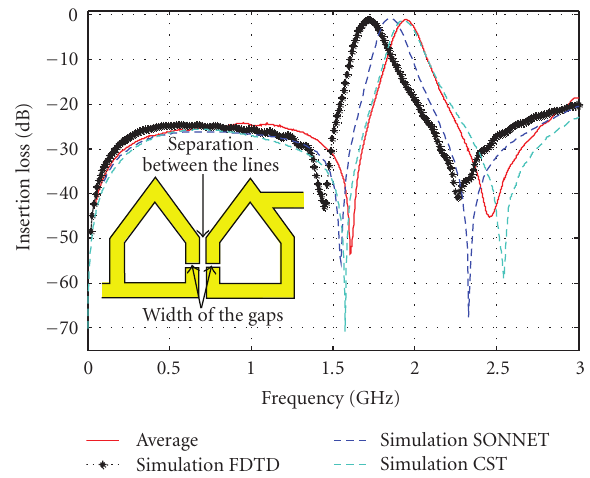
Figure 1: Comparison between average, FDTD, SONNET, and CST.